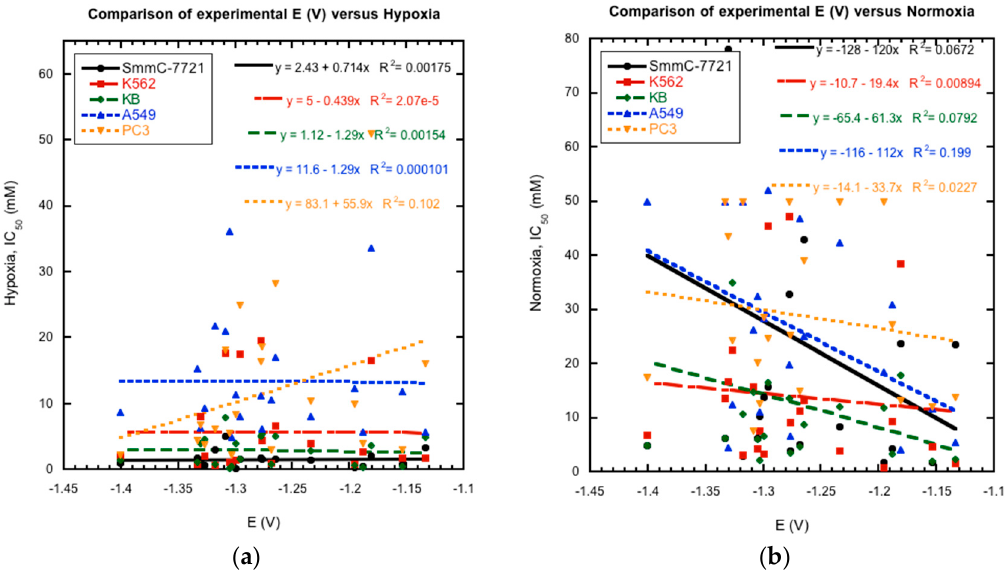
Figure 6. The comparison of experimentally measured reduction potentials for wave 1 (1st N -oxide reduction) to the previously reported IC 50 ( μ M) for five cancer cell lines under ( a ) hypoxic and ( b ) normoxic conditions clearly shows no correlation. Hypoxia = 3% oxygen, Normoxia = 20% oxygen.